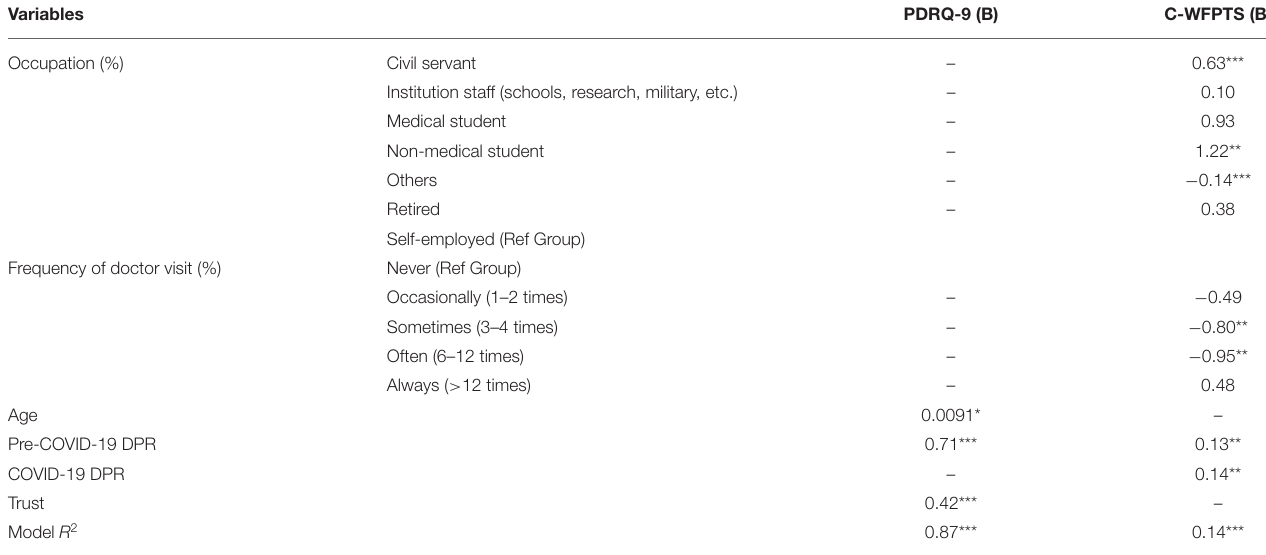
TABLE 3 | Regression weights of trust in doctors and the doctor–patient relationship.